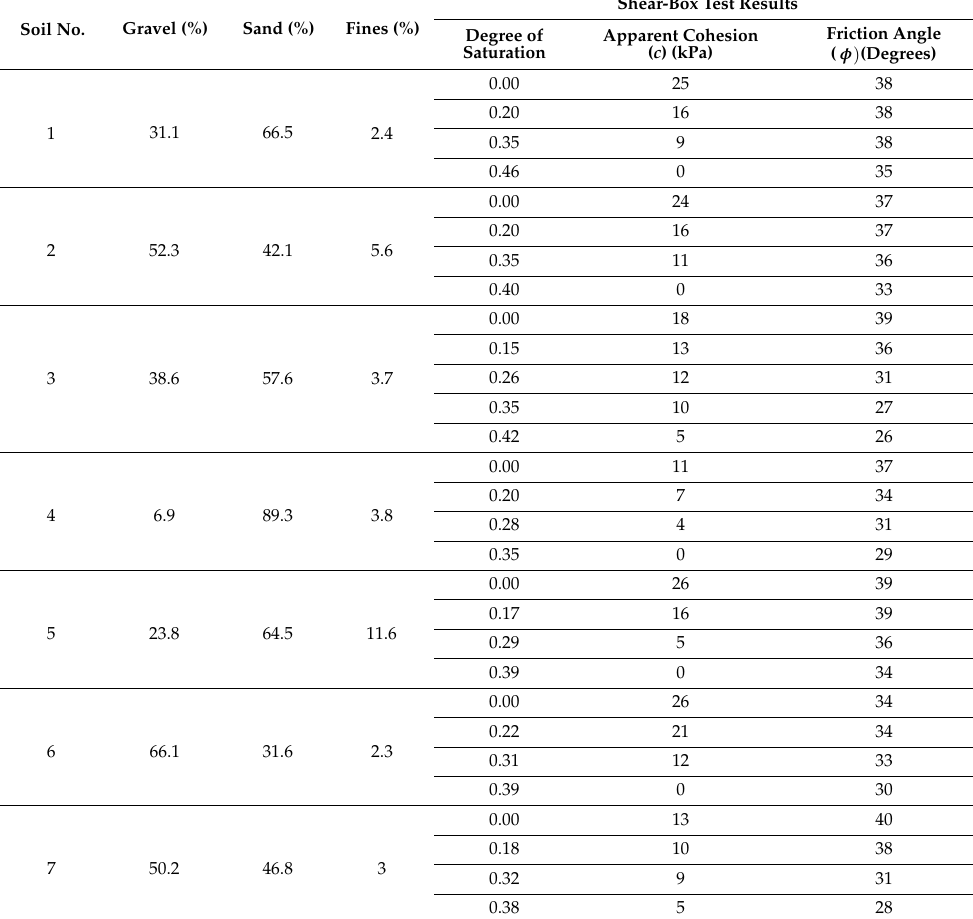
Table 1. Summary of properties of soils from landslide